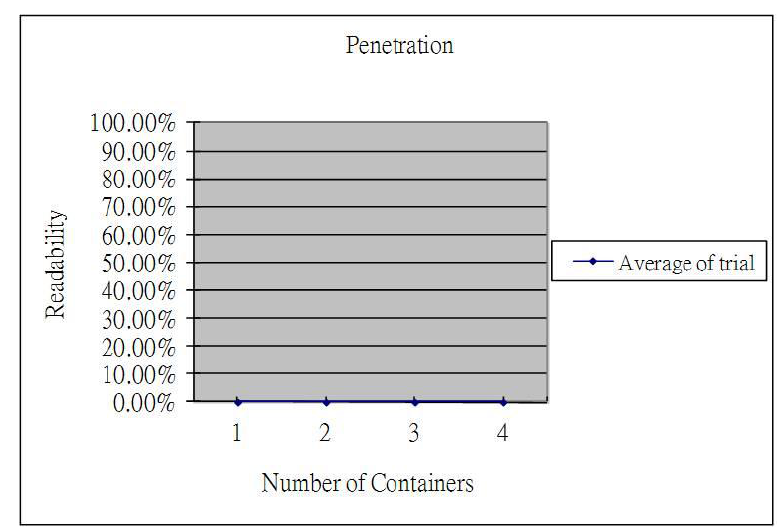
Figure 16. Relationship readability and distance in cross